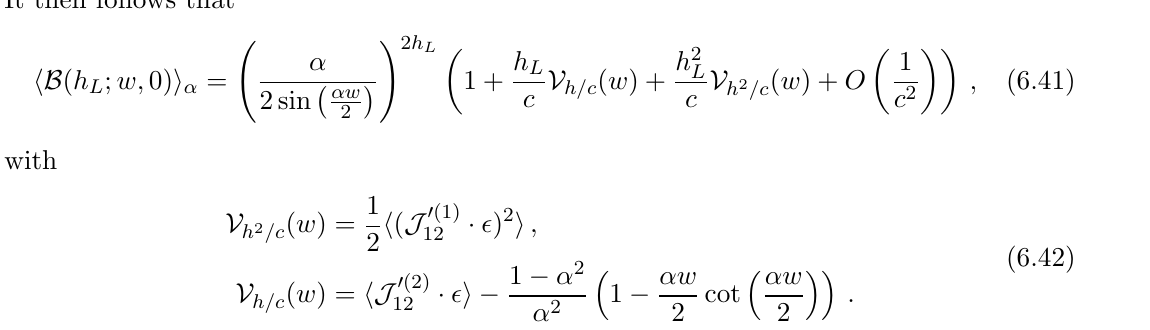
Figure 4 . The one-loop diagram which gives the O (1 =C ) correction to the identity block in the heavy-light limit. The coupling to the reparameterization (cid:12)eld is given by h It then follows